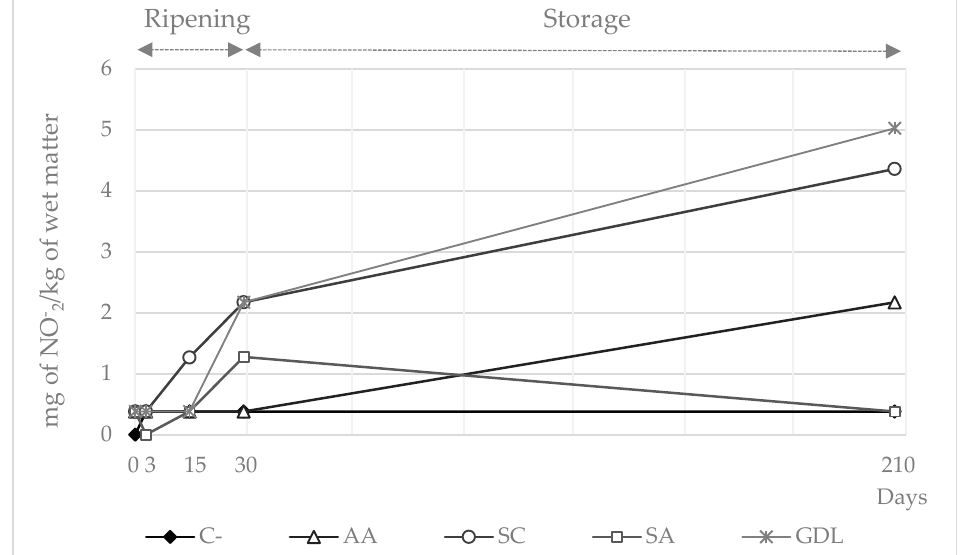
Figure 2. Nitrite concentration (mg/kg of wet matter) in sausages manufactured with different reducing agents added during ripening and storage periods (days). C- = negative control; AA = ascorbic acid; SC = starter culture; SA = sodium ascorbate; GDL = glucono-delta-lactone.